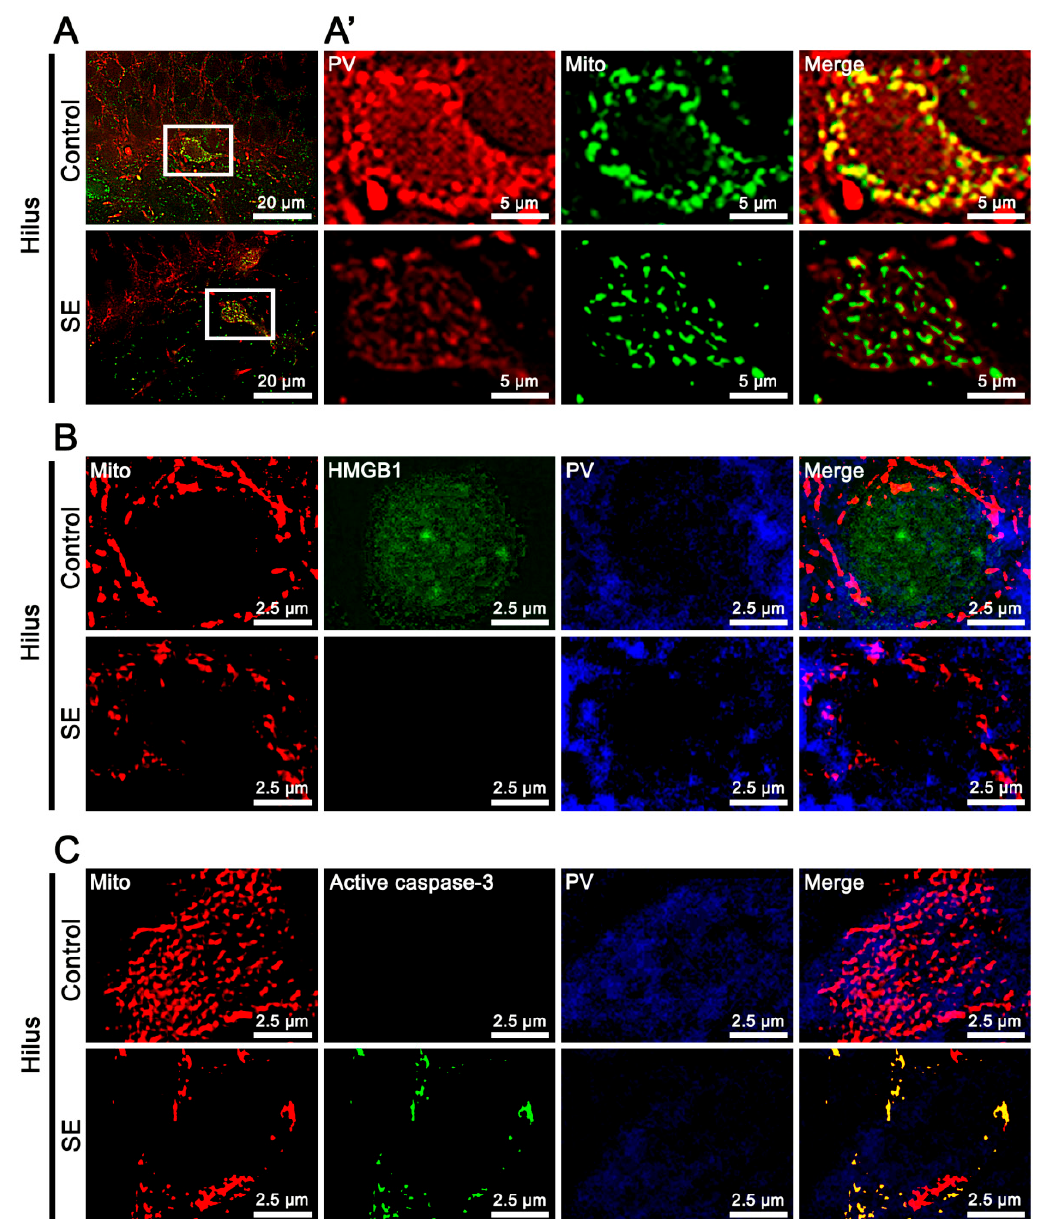
Figure 1. Mitochondrial accumulations of high mobility group box 1 (HMGB1) and active caspase-3 in parvalbumin (PV) neurons following status epilepticus (SE). ( A ) Reductions in PV expression and mitochondrial length in the hilus. ( A’ ) shows high magnifications of rectangles in the left panels. ( B ) Absence of translocation of HMGB1 from nucleus to mitochondria (Mito) accumulation in PV neurons following SE. ( C ) Mitochondrial active caspase-3 in PV neurons following